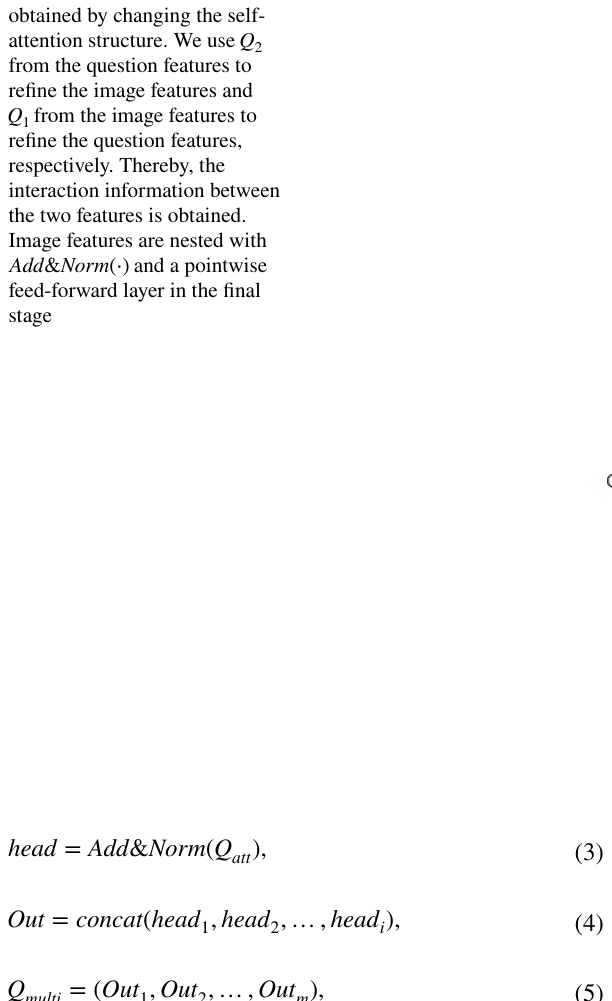
Fig. 3 The process of mutual attention module, which is obtained by changing the self- attention structure. We use Q 2 from the question features to refine the image features and Q 1 from the image features to refine the question features, respectively. Thereby, the interaction information between the two features is obtained. Image features are nested with Add & Norm ( ⋅ ) and a pointwise feed-forward layer in the final